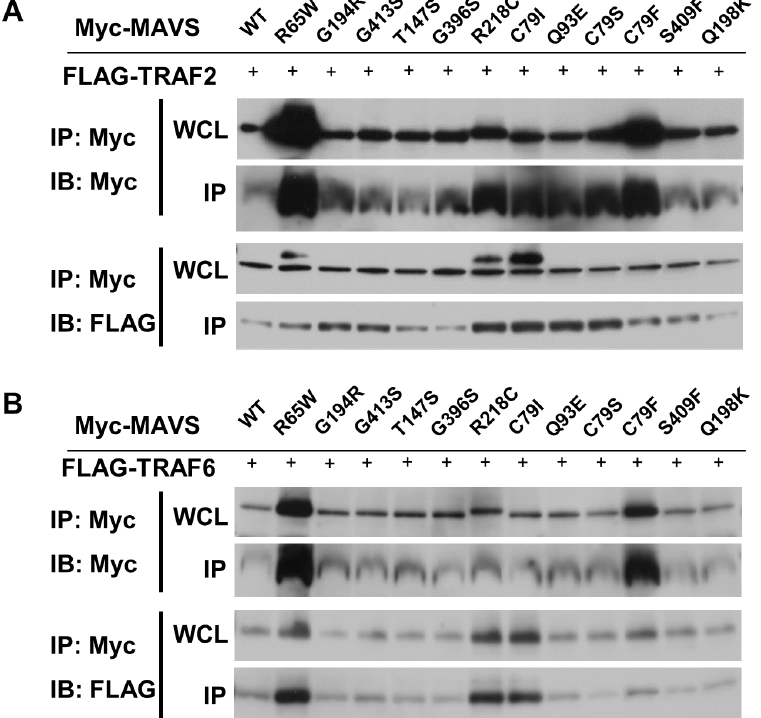
Fig 5. Effects of MAVS SNPs on association with RIG-I, TRAF2, and TRAF6. Twenty-four hours after co- transfection with a Myc-tagged WT or variant MAVS expression plasmid and p3xFLAG-TRAF2 (A) or p3xFLAG-TRAF6 (B), cell lysates were immunoprecipitated with Myc beads. The eluted proteins were then analysed by IB with an antibody against FLAG or Myc, as indicated. The WCL represents 3% of the starting materials used for IP.